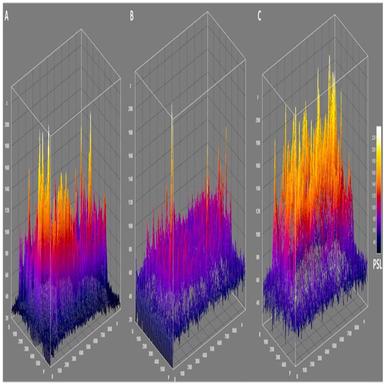
Digital autoradiography of soils collected from the a) Fen, b) Søve and c) Bolladalen sites reflects inhomogeneous distributions of radioactivity. Read-out signals from the exposed image plates are reported as PhotoStimulable Luminescence (PSL).